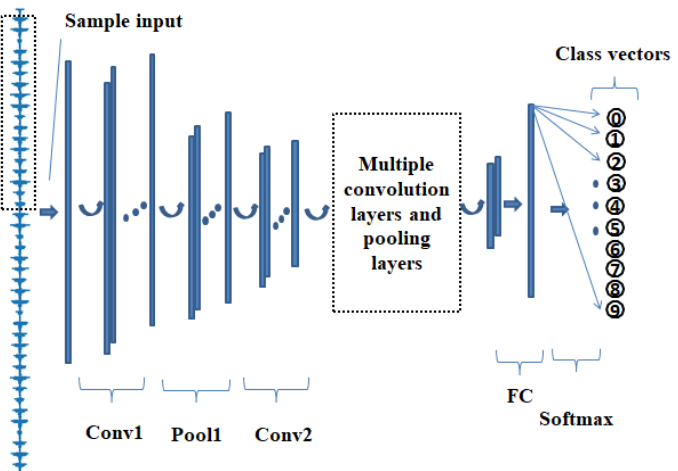
Figure 2. Schematic diagram of ACNN-W.